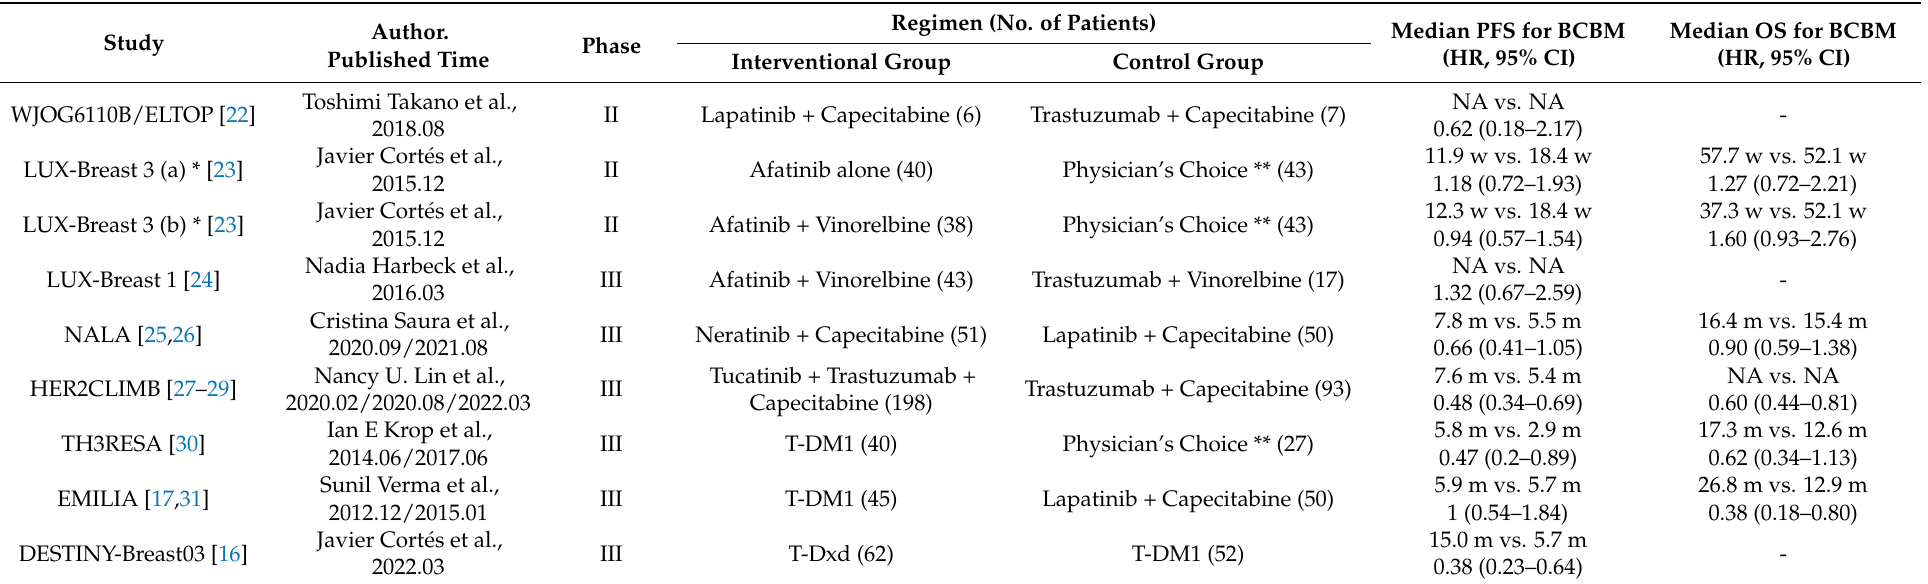
Table 1. The baseline characteristics and survival outcomes of the included